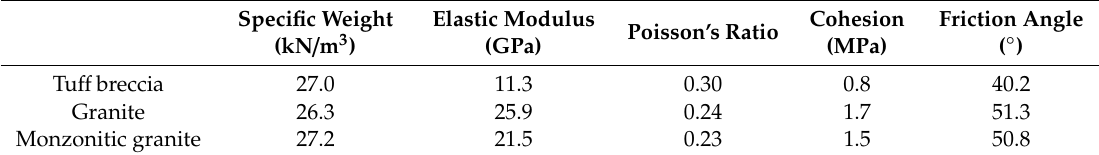
Figure 4. Longitudinal geological profile of the project area. Table 2. The typical physical and mechanical properties of the surrounding rock.